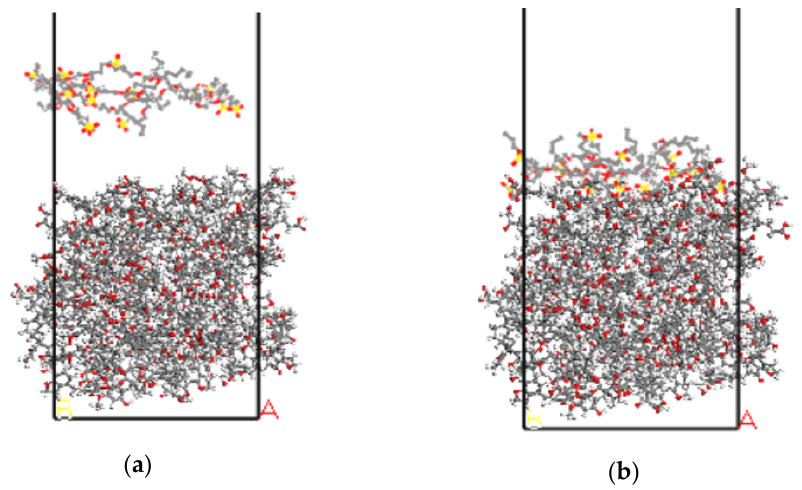
Figure 2. Initial ( a ) and final ( b ) adsorption configurations of S2-lignite system.